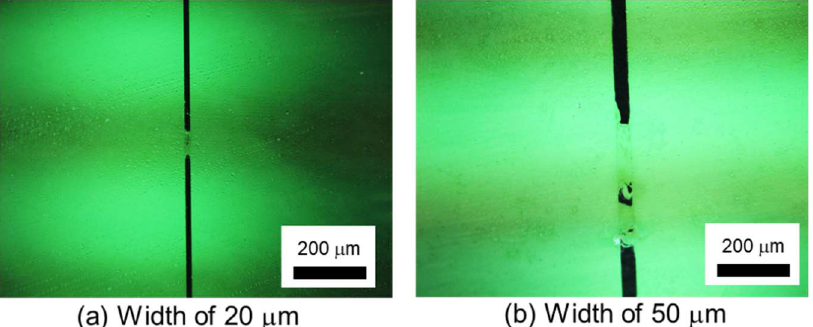
Figure 6. Images of the damaged electrodes. ( a ) The electrode with a width of 20 μm. ( b ) The electrode with a width of 50 μm.